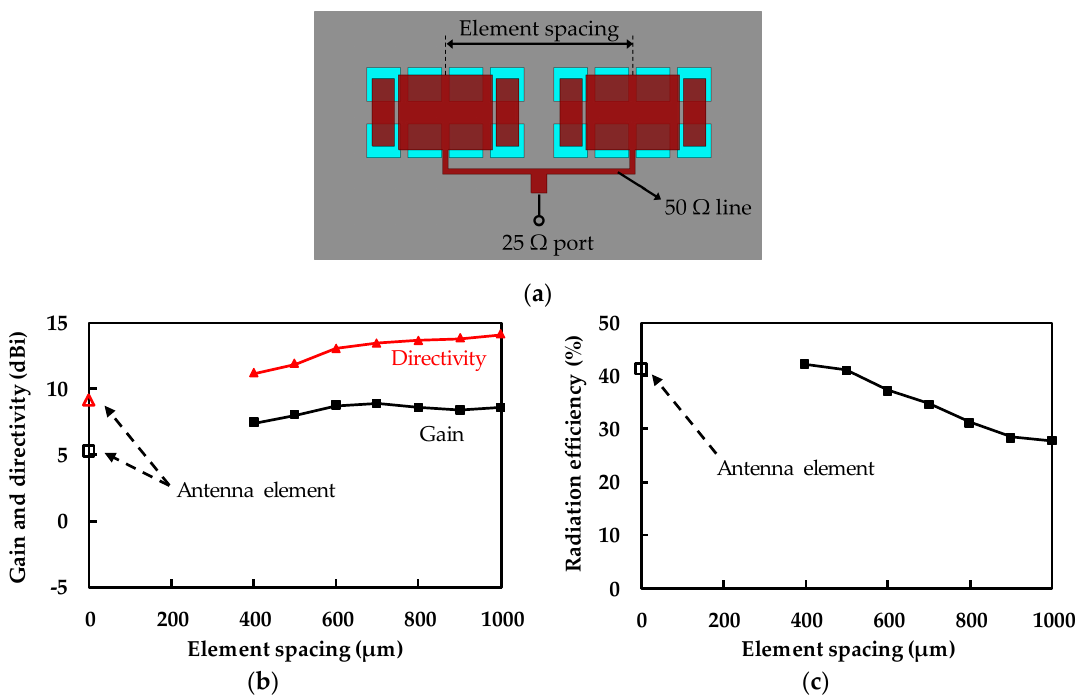
Figure 5. Simulated performance of 1 × 2 antenna array using the proposed patch with DGS at 300 GHz as a function of element spacing. ( a ) The 1 × 2 antenna array with termination impedance of 25 Ω . ( b ) Gain and directivity. ( c ) Radiation efficiency.